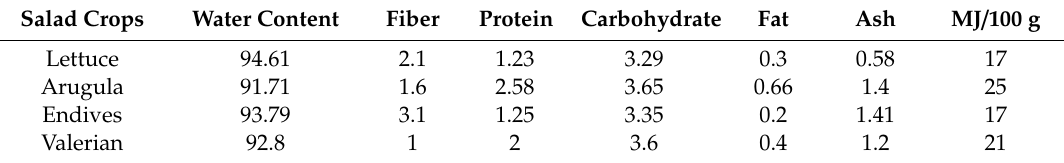
Table 2. Chemical composition of most consumed salad crops (g/100 g of fresh material).